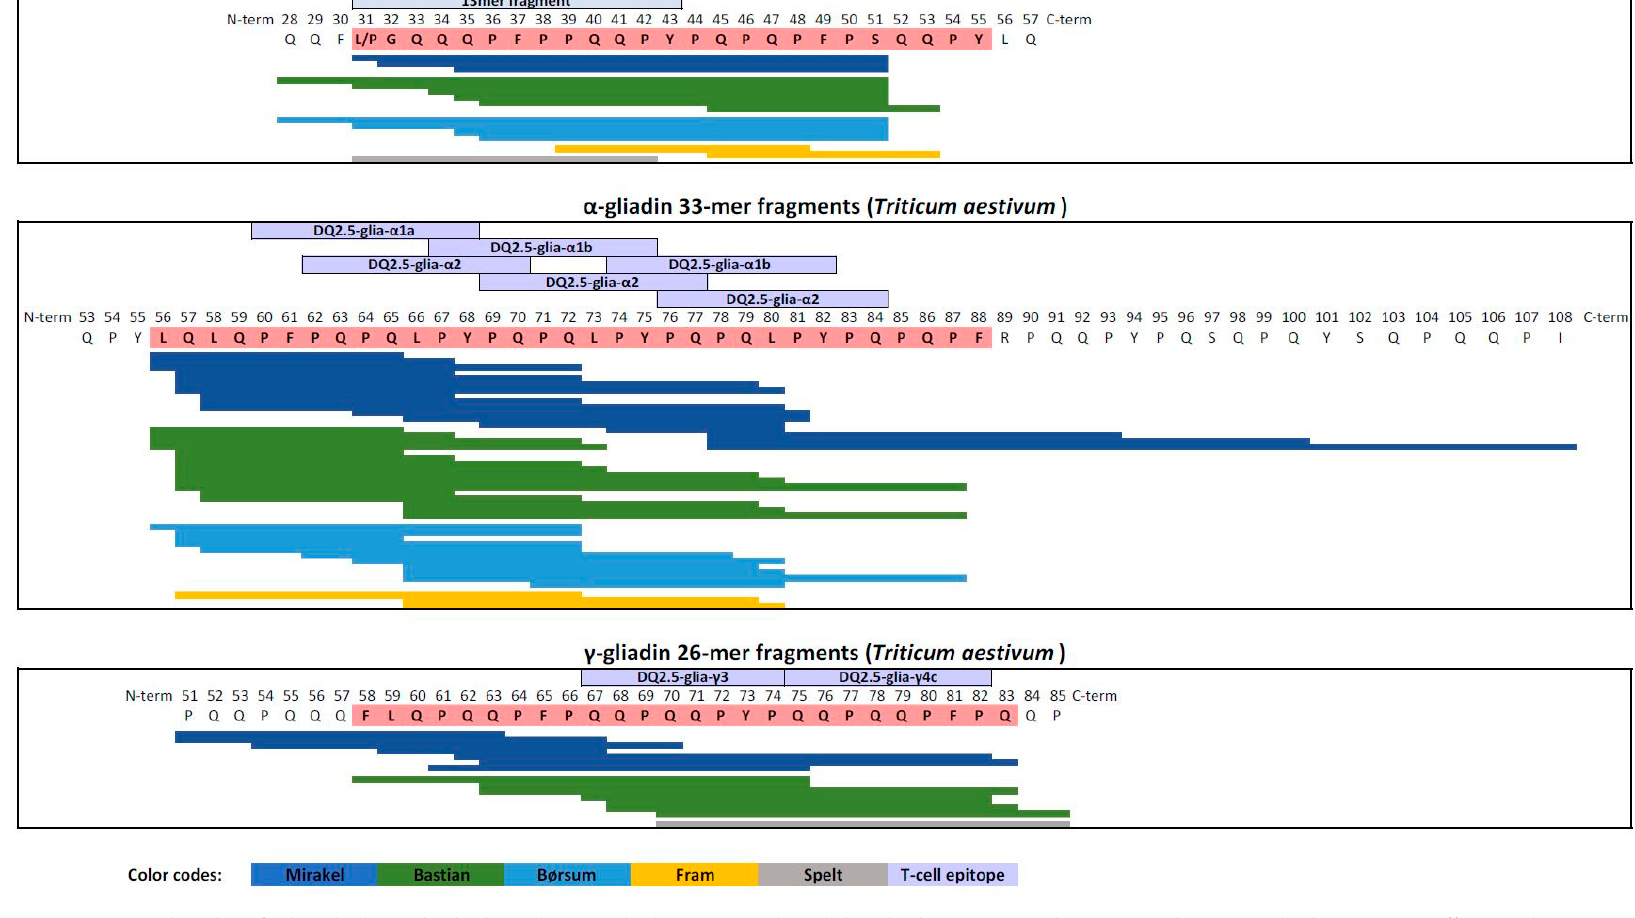
Figure 2. Peptides identified in the hexaploid wheat digests which correspond to alpha-gliadin 33-mer and 25-mer, and gamma-gliadin 26 mer. Different wheat types are represented by different colours: Mirakel, dark blue; Bastian, green; Børsum, light blue; Fram, yellow; spelt, grey. Known T cell epitopes within the illustrated sequences are presented in purple above the sequence.